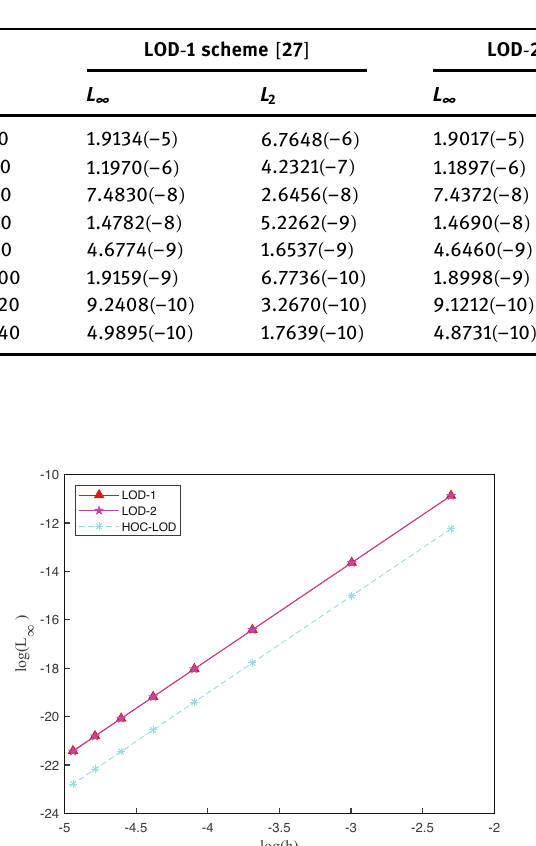
Table 3: L 2 , L ∞ errors when = τ h 0.2 and = T 0.2 for Example 1